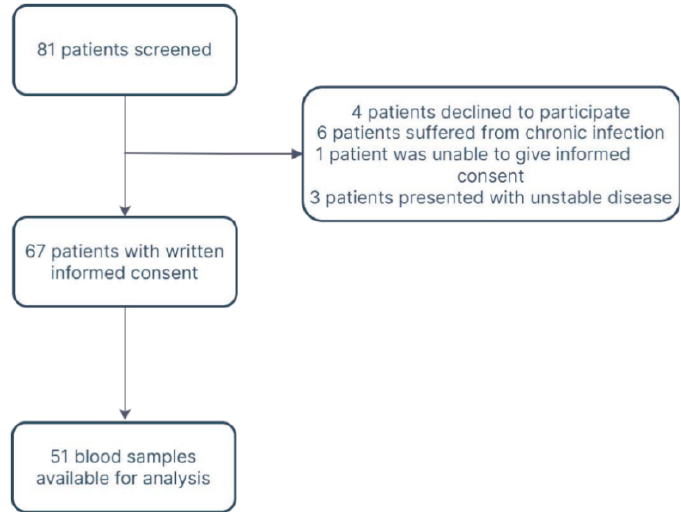
Figure 1. Flow diagram.